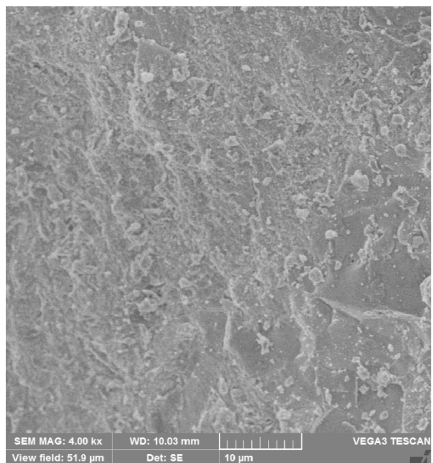
Figure 12: Microstructure of 0.3% SAP.